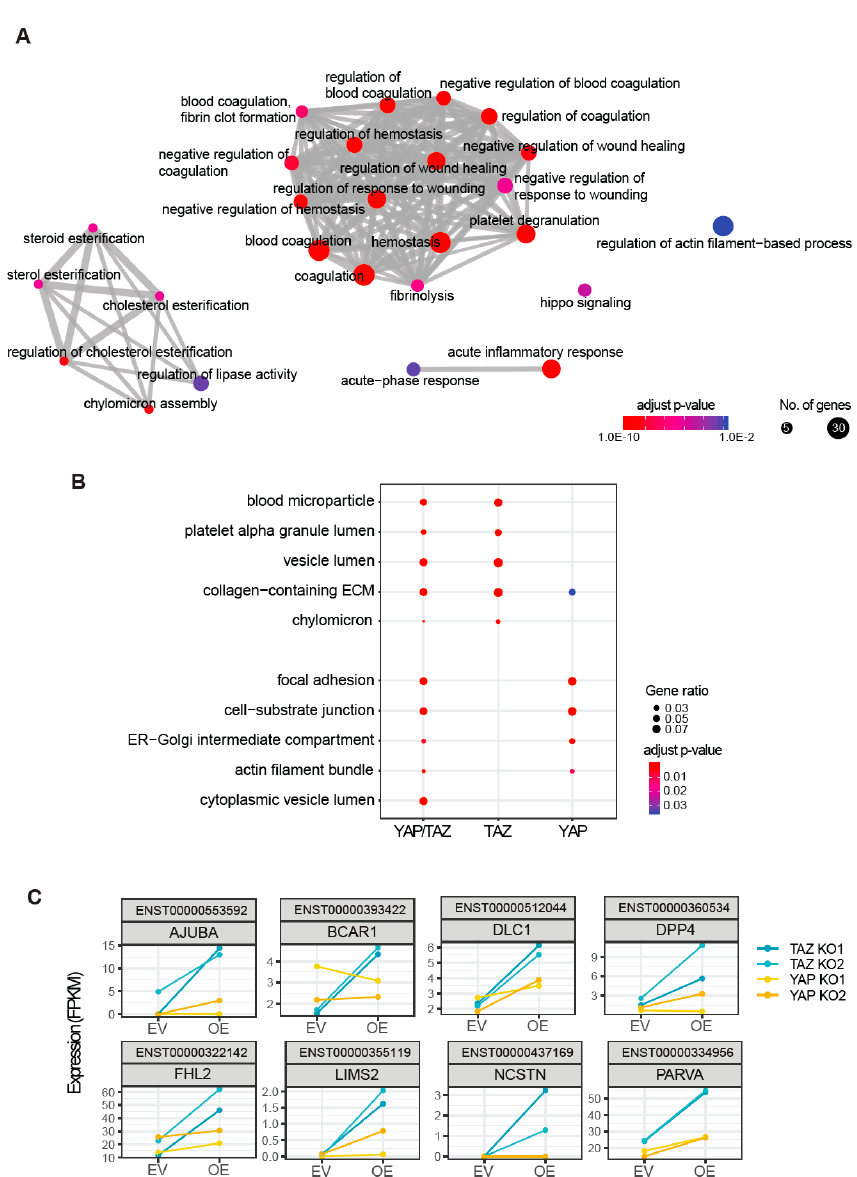
Figure 3. Gene Ontology (GO) analysis of YAP- and TAZ-transcriptional targets. ( A ) Biological process GO terms that are significantly enriched for the union of upregulated YAP targets and TAZ targets. Each GO term is depicted as a node (i.e., dot) and one node is connected to another node by an edge (i.e., line) if there is a significant overlap between the gene sets. The node size corresponds to the number of genes in the set and the node colour indicates the statistical significance of a GO term enrichment test. ( B ) The most significant cellular component GO terms for the up-regulated genes by YAP/TAZ (the union of YAP and TAZ), TAZ, and YAP. The dot size indicates a gene ratio, the number of genes in the input list associated with the given GO term, and then divided it by the total number of input genes. The dot colour depicts the statistical significance of a GO term enrichment test. ( C ) Representative genes assigned to the YAP-specific GO terms: focal adhesion (FA) and cell-substrate junction. Each box shows the expression level of a gene, measured by RNA-seq. The respective Ensembl transcript ID and gene symbol are shown on the top of each box. The Y-axis is expression level in Fragments Per Kilobase Million (FPKM). The X-axis indicates control and treatment groups: empty vector (EV) and overexpression (OE). Two TAZ KO clones and two YAP KO clones are depicted in blue and ochre, respectively. In other words, EV and OE in TAZ KO clones (blue) indicates YAP N and YAP OE , and EV and OE in YAP KO clones (ochre) means TAZ N and TAZ OE